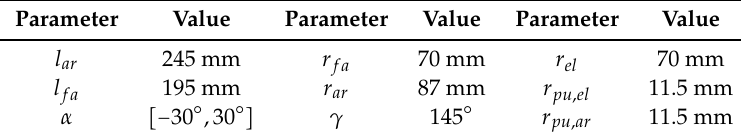
Table 1. CADEL.3 dimensions used for the simulation (Figure